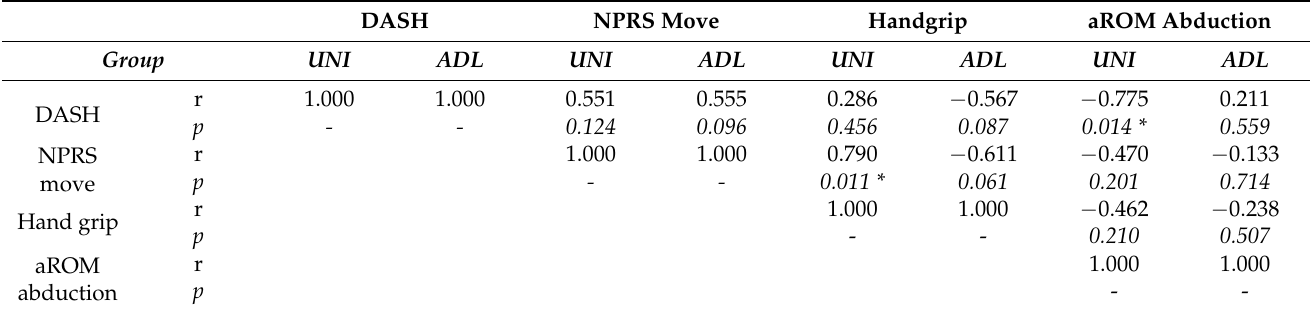
Table 2. Correlations of DASH, movement pain (NPRS), grip strength, and active ROM for abduction in the UNI-group (n = 9) and the ADL-group (n = 10) at the end of rehabilitation (t2). DASH NPRS Move Handgrip aROM